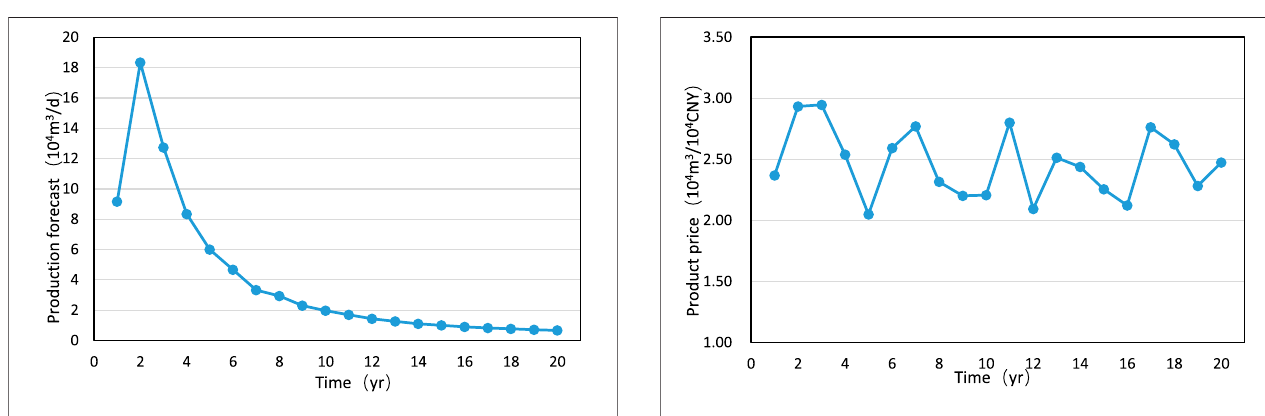
FIGURE 2 | The gas production forecast of the gas well. FIGURE 3 | The price of quali fi ed natural